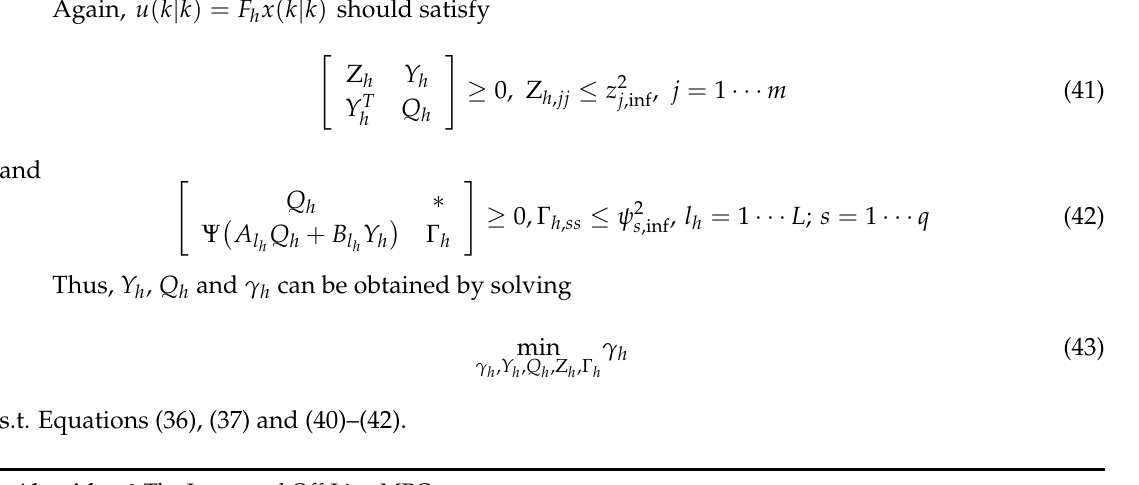
Algorithm 2 The Improved Off-Line MPC